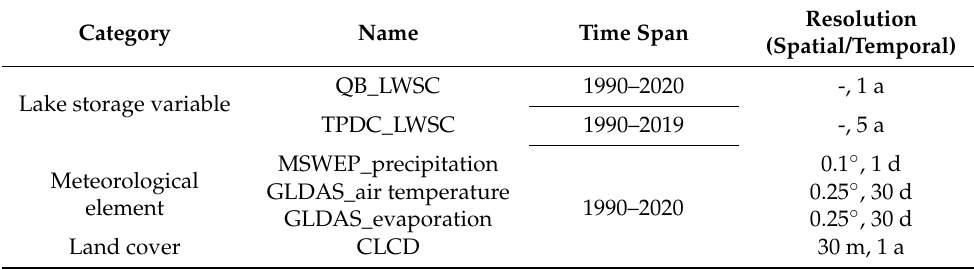
Table 2. Data used in this